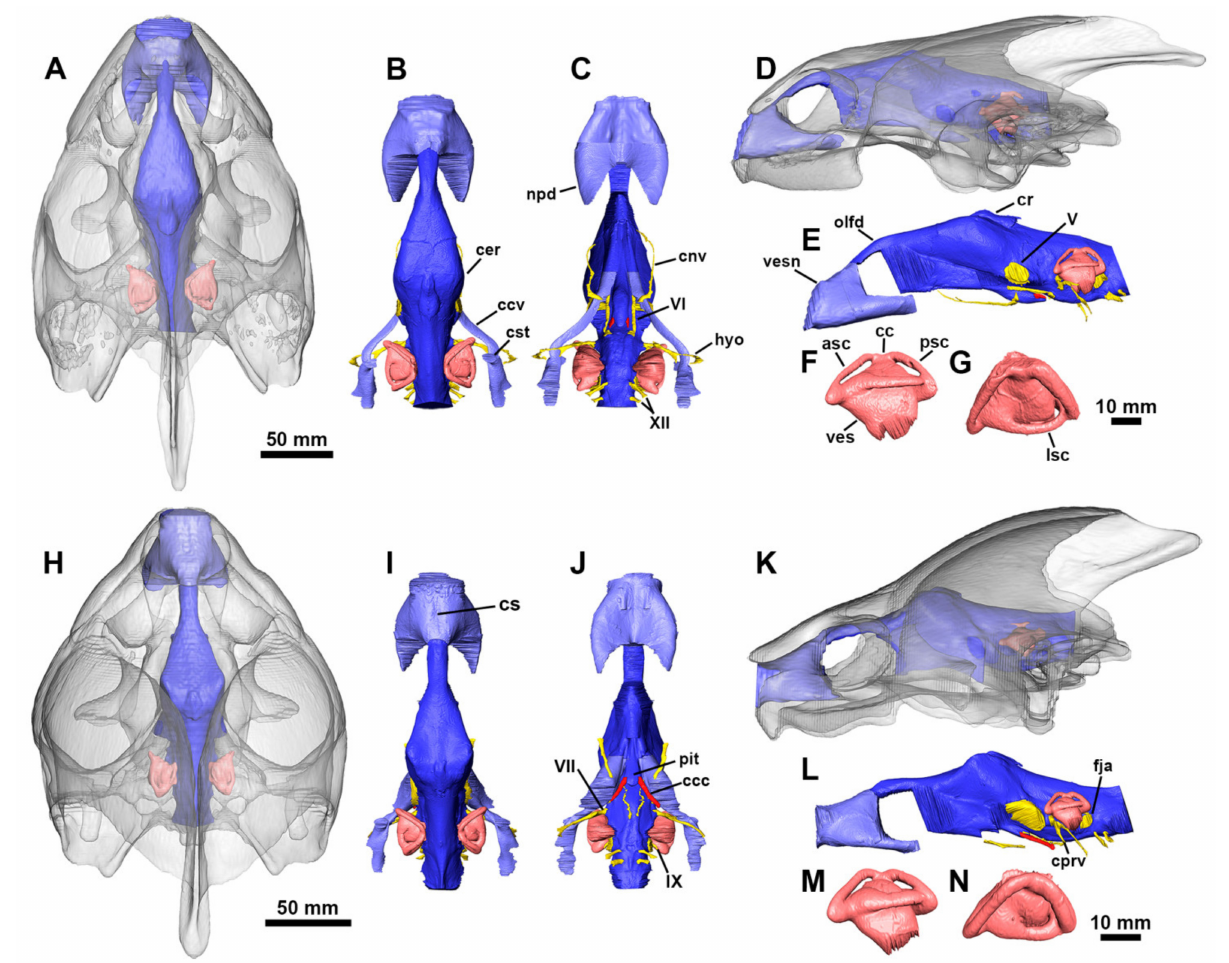
Figure 7. Osteological and neuroanatomical three-dimensional virtual reconstructions of the extant podocnemidids Podocnemis unifilis (MACV 2667; ( A – G )) and Erymnochelys madagascariensis (MNHN.ZA.AC 1946-71; ( H – N )). The osseous elements (in grey) have been visualized as transparent ( A , D , H , K ) in order to show the reconstruction of the endocast of cranial and nasal cavities (in blue) ( B , C , E , I , J , L ). The reconstructions are presented in dorsal ( A , B , H , I ), ventral ( C , J ), and left lateral ( D , E , K , L ) views. Reconstruction of the left inner ears of these taxa ( F , G , M , N ) in lateral ( F , M ) and dorsal ( G , N ) views. Abbreviations: asc, anterior semicircular canal; cc, crus communis; ccc, canalis caroticus cerebralis; ccv, canalis cavernosus; cer, cerebral hemisphere; cnv, canalis nervi vidiani; cprv, canalis pro ramo vidiani; cr, cartilaginous ridge; cs, cartilaginous septum; cst, canalis stapedio-temporalis; fja, foramen jugulare anterius; hyo, hyomandibular branch of facial nerve; ie, inner ear; IX, glossopharyngeal nerve; lsc, lateral semicircular canal; nc, nasal cavities; npd, nasopharyngeal duct; olfd, olfactory duct; olfr, olfactory region; pit, pituitary fossa; psc, posterior semicircular canal; V, trigeminal nerve; ves, vestibulum; vesn, vestibulum nasi; VI, abducens nerve; VII, facial nerve; VIII, vestibulocochlear nerve; XII, hypoglossal